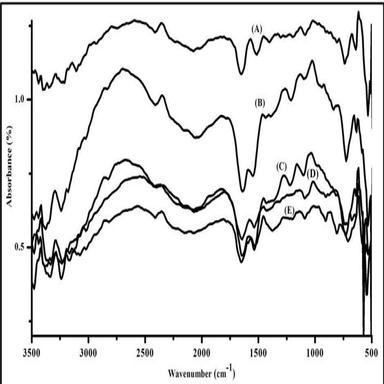
FTIR spectra for the various functional group analysis: (A) PVA/AlgNa þ enzyme beads; (B) PVA/AlgNa; (C) AlgNa; (D) PVA; (E) PVA/AlgNa beads.